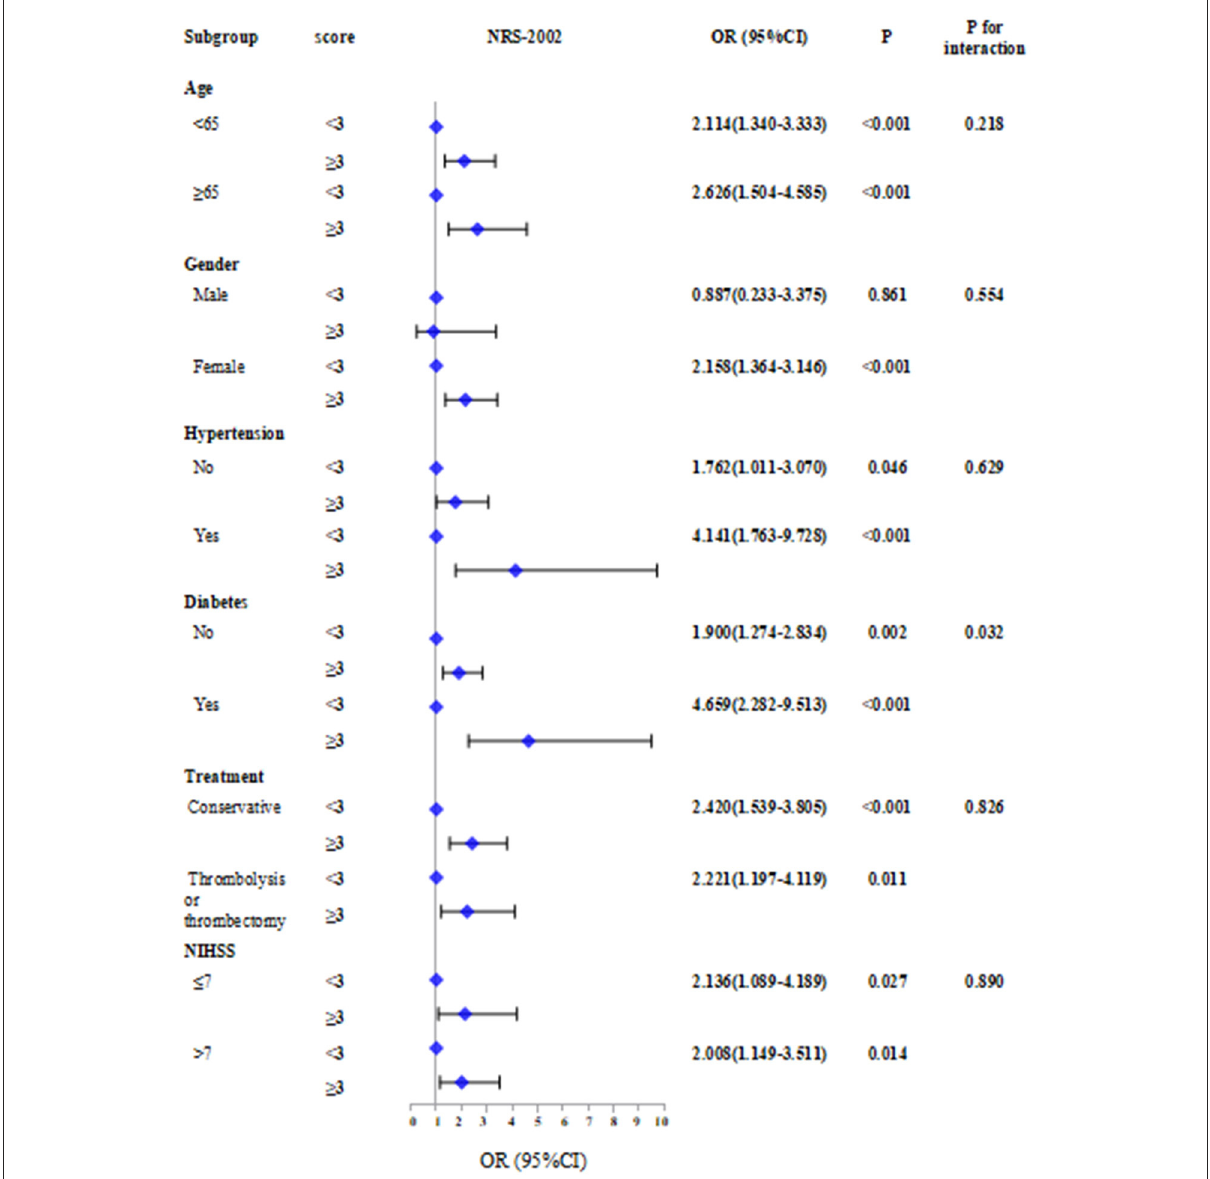
FIGURE3 Subgroup analyses stratified by age, sex, hypertension, diabetes, treatment and NIHSS score.The absent of malnutrition group was used as reference in Logistic regression models.